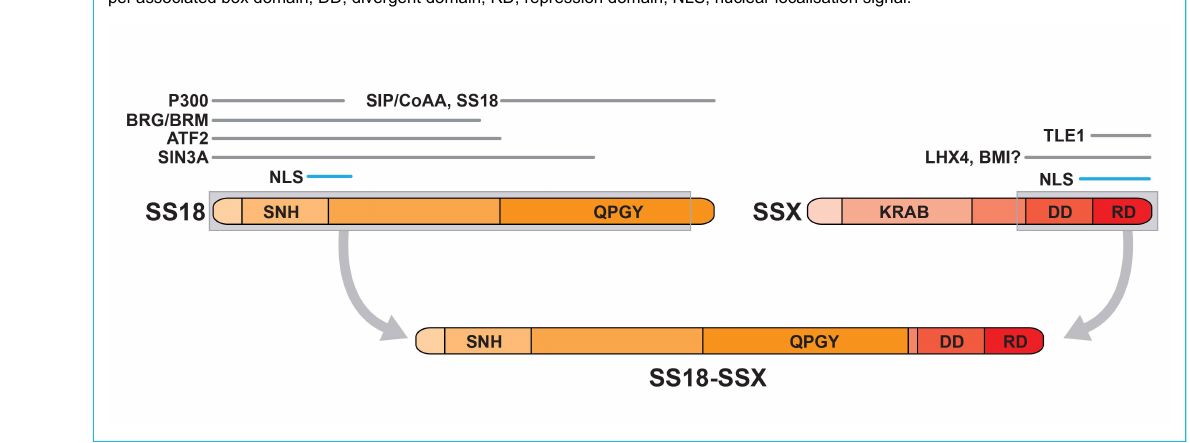
Figure 2: The SS18-SSX fusion protein. Illustration of the domain structure of SS18 and SSX and the regions within each that support inter- action with the indicated proteins. The grey encasing indicates the segments of each partner that form part of the fusion protein (below). The indicated fusion partner domains are: SNH, SS18 N-terminal homology; QPGY, glutamine-proline-glycine-tyrosine-rich domain; KRAB, Krup- pel-associated box domain; DD, divergent domain; RD, repression domain; NLS, nuclear localisation